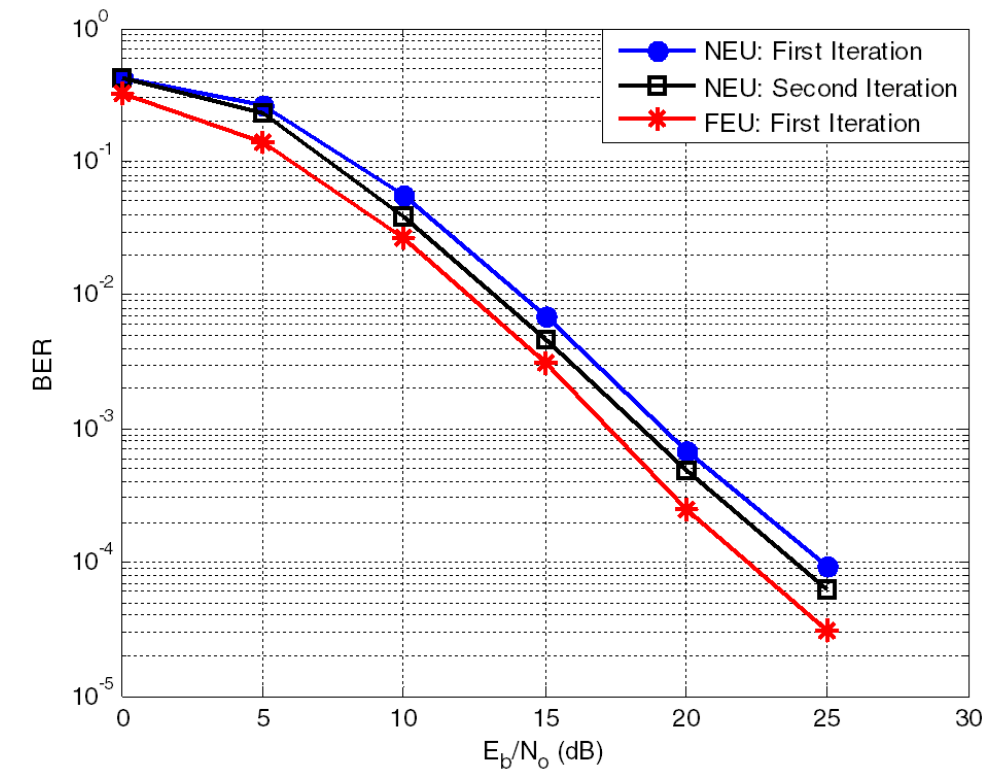
Figure 10. BER performance comparison of different receivers for NEU and FEU with P 1 , P 2 =